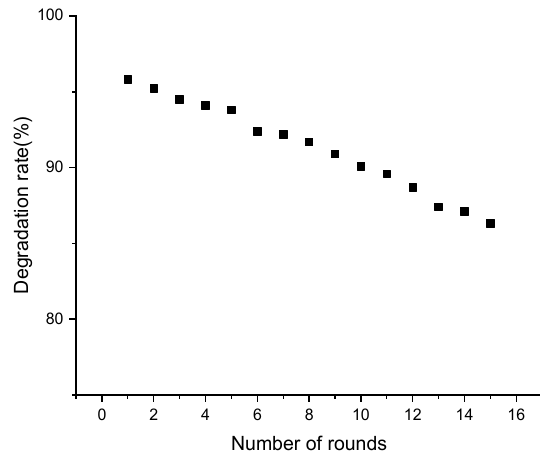
Figure 8. Cycling runs of the composite photocatalyst.